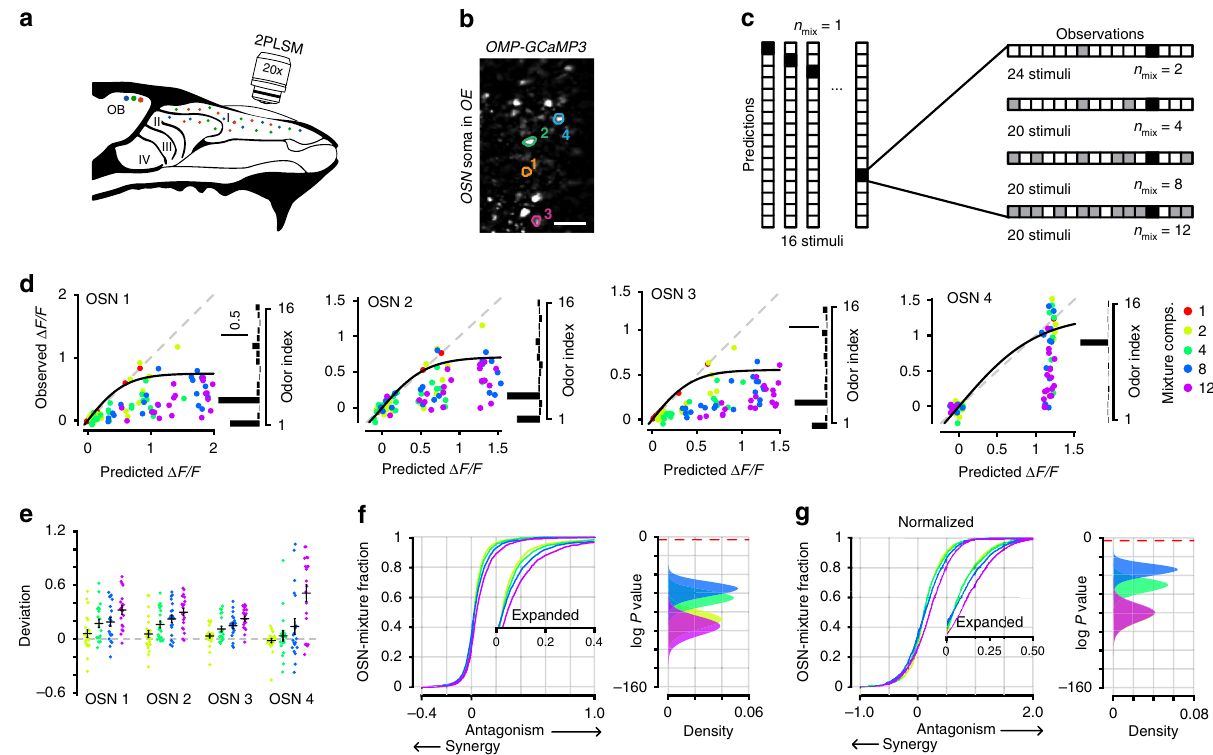
Fig. 7 Antagonism through complex mixtures in single neurons. a Experimental setup for imaging OSN somata in the epithelium. b Example image of OSN somata and selected ROIs from one of three mice used in this dataset. Scale bar in image is 20 µ m. c Stimulus design for complex mixtures. OSN responses to each of 16 components are measured. Odor mixtures are made from subsets of 2, 4, 8, or 12 of the 16 individual odor components. d Example mixture responses from the OSNs outlined in ( b ). Each point is the average of three trials. The data from each OSN is fi t with a sigmoid that re fl ects the maximum response from that cell. Odor tuning pro fi le for each OSN is shown on the right. Scale bar units are Δ F/F. e Deviation from each mixture response to the sigmoidal fi t the data. Positive values re fl ect antagonism and negative values re fl ect synergy. For each OSN: n = 24 2-part mixtures, n = 20 4-part mixtures, n = 20 8-part mixtures, and n = 20 12-part mixtures. Mean of all mixtures of a given complexity is the horizontal black bar and error is SEM. f Cumulative distribution of all deviations from the sigmoidal fi t for each mixture complexity. Data collected from 129 OSNs in three mice. Expanded traces are inset. Right, histogram of bootstrapped P value distributions for each mixture complexity, testing the signi fi cance of the observed deviations from the sigmoidal fi t against a null distribution. 500 random deviations for each mixture complexity were selected and compared with distributions with a vanishing mean and the same standard deviation using a two-sample Kolmogorov – Smirnov test. This process was repeated 100,000 times. Red horizonal dashed line corresponds to P values = 0.05. g Data were normalized for each OSN by dividing each mixture response by the asymptote of the sigmoidal fi t to the data. Antagonism is not overrepresented in a small number of strongly responding input to the olfactory system may be normalized through mixture